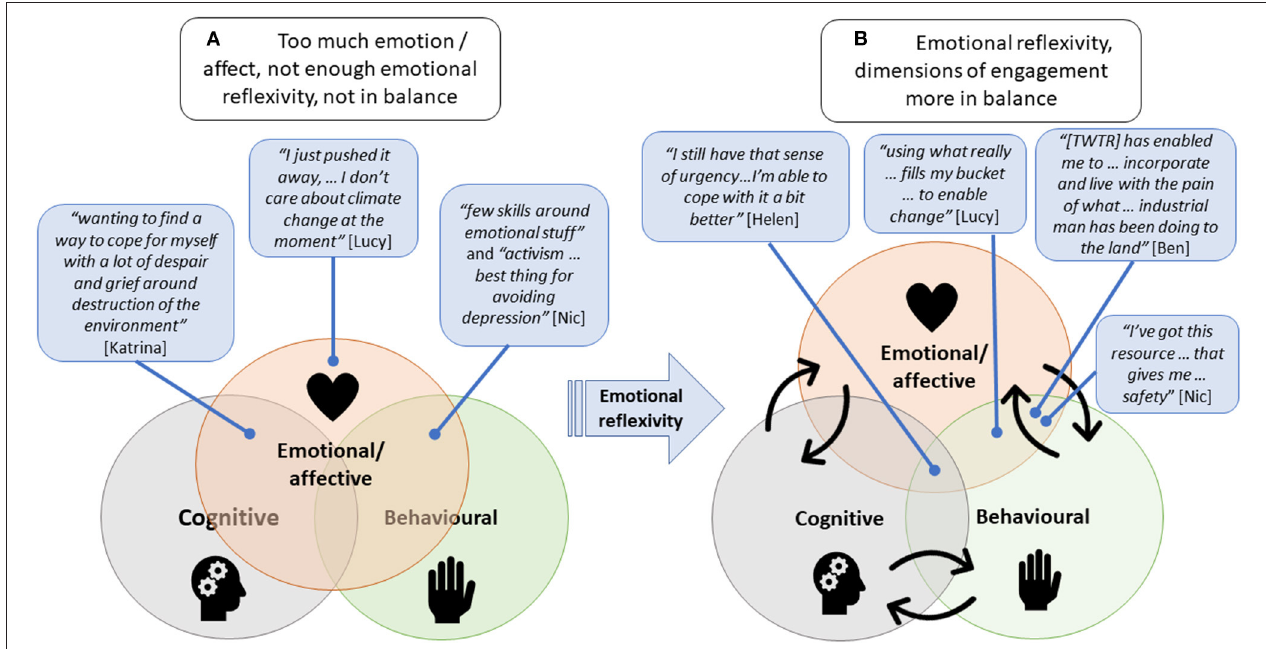
FIGURE 3 | (A,B) Development of emotional reflexivity for those motivated by coping mechanisms. Symbols: Heart: emotional/affective dimensions. Head: cognitive dimensions; Hands: behavioral dimensions; Arrows: feedback between the dimensions; Blue speech bubbles: quotes from participants; Tension between the dimensions; Process of participation in the CLP or